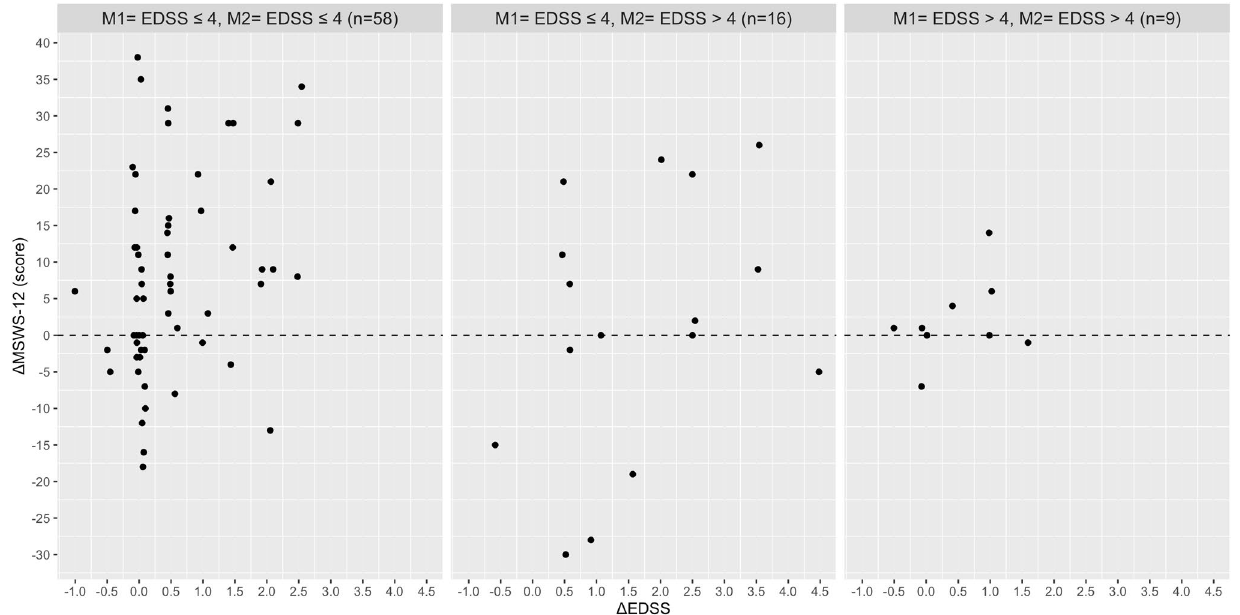
Figure 5. Relationship between the absolute change in the MSWS-12 with absolute change in the EDSS score according to disability subgroups.